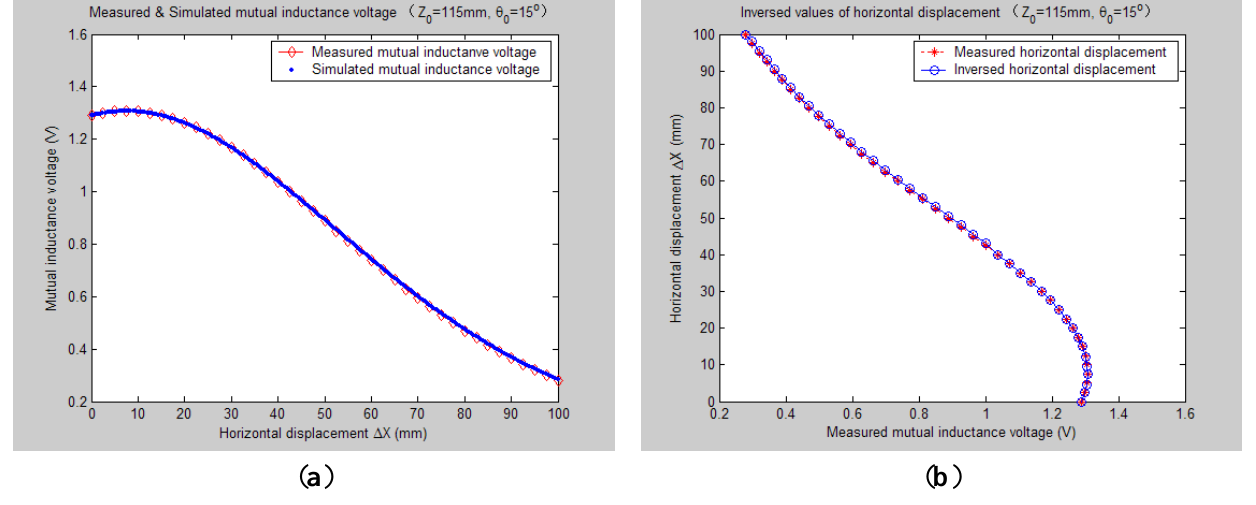
= 15°, Z = 115 mm). 0 0